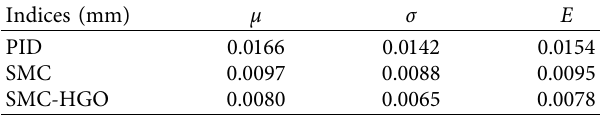
Table 2: Performance indices for multifrequency sinusoidal signal. Indices